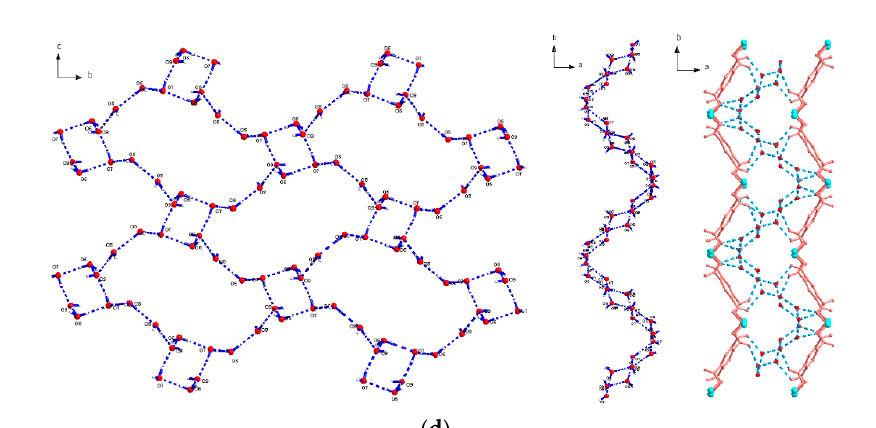
Figure 3. ( a ) Distorted tetrahedral geometry of Zn(II) ion in 2 with atom labeling scheme (ORTEP drawing, 30% thermal ellipsoids). H atoms and guest water molecules are omitted for clarity. ( b ) A 2D sinusoidal-like layered framework built up via the bridges of Zn(II) ions and BT 4 − ligands, viewed along the a axis (left) and c axis (right), respectively. ( c ) A 3D MOF built up via the bridges of 2D [Zn 2 –BT] layers (orange-red) and bpp ligands (green) viewed along the a axis (left) and c axis (middle). Right: the Zn ⋅⋅⋅ Zn distances via BT 4 − ligand bridges. ( d ) Left: the sinusoidal-like water layer viewed along the a axis. Middle: the sinusoidal-like water layer viewed along the c axis. Right: the synergistic interactions between 2D water hydrogen-bonded layer and two [Zn 2 (BT)] n layers.